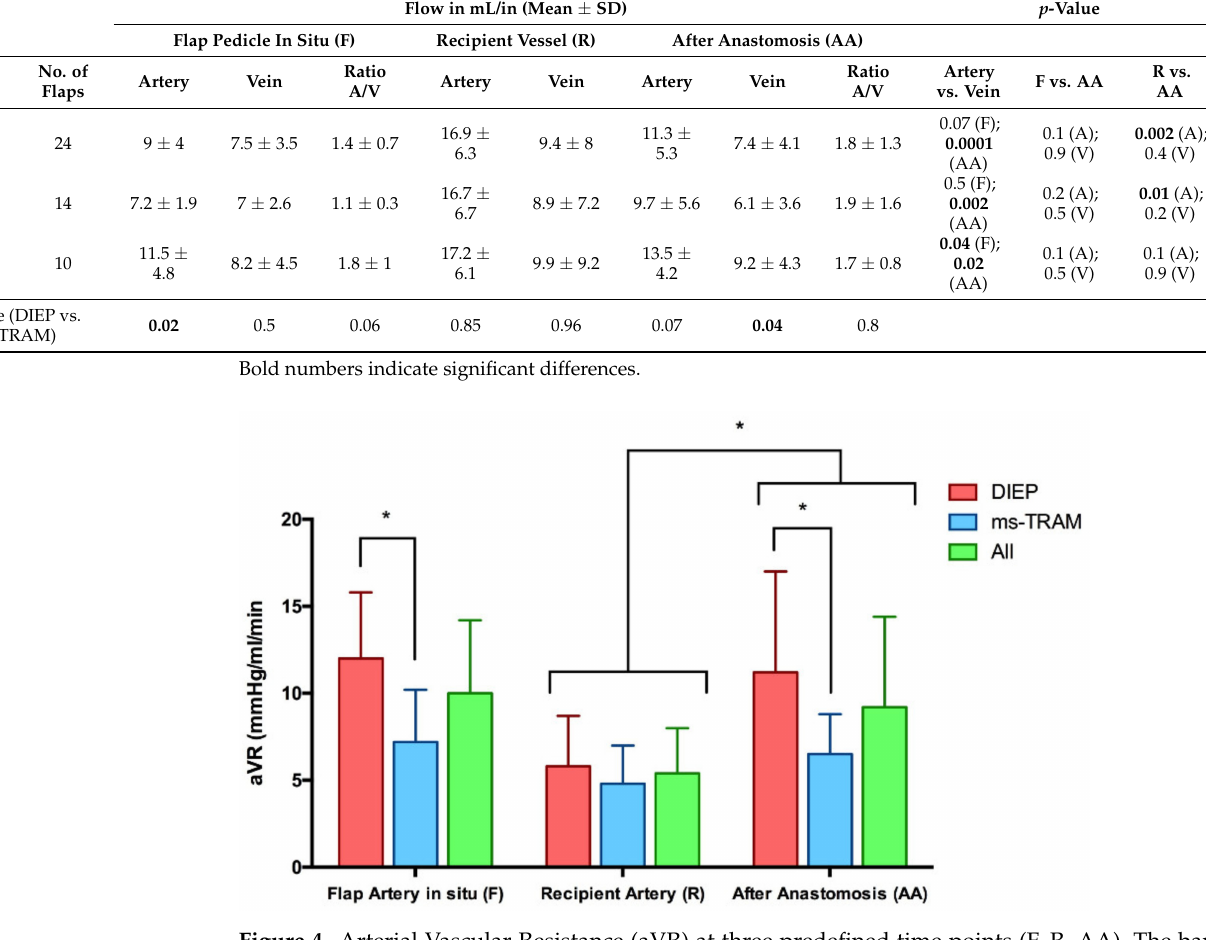
Figure 4. Arterial Vascular Resistance (aVR) at three predefined time points (F, R, AA). The bars represent means ± standard error (* indicates significant differences). Table 3. Comparison of Arterial Vascular Resistances (mmHg/mL/min) of the flap pedicle in situ (F), of the Recipient Artery (R) and After Anastomosis